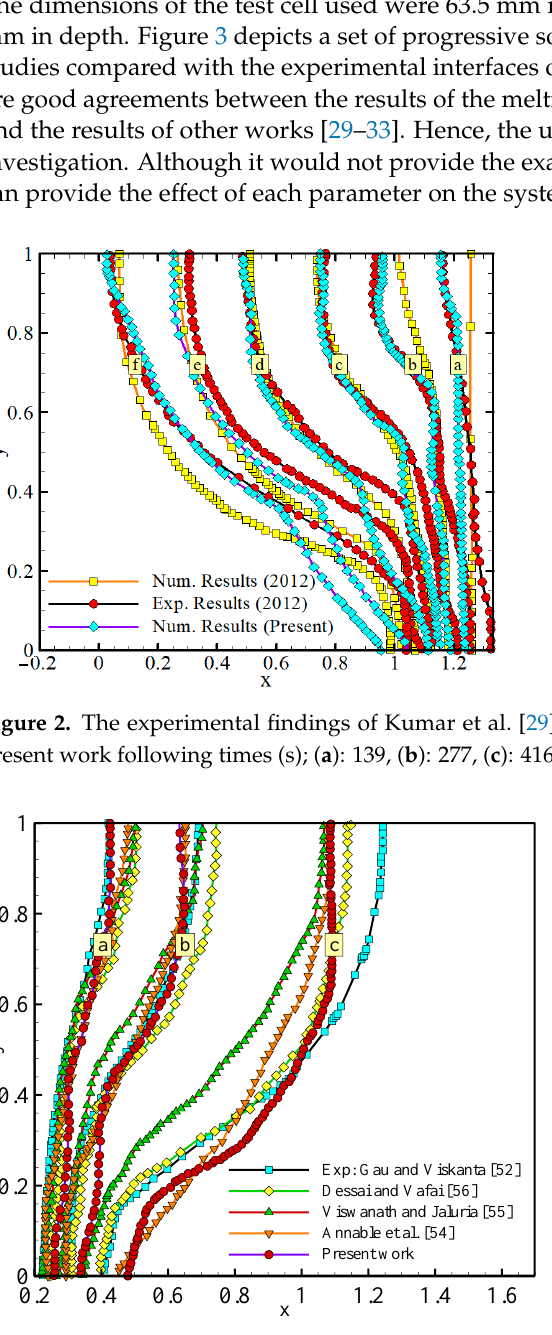
Figure 3. Melting lines for several studies in literature and present work for ( a ): t = 5 min, ( b ): 10 min, and ( c ): 19 min.